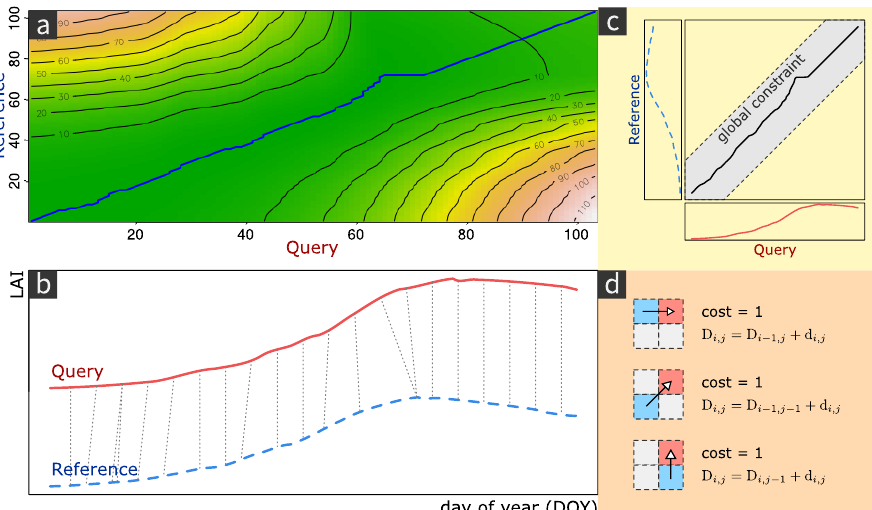
Figure 5. Dynamic time warping (DTW) algorithm and its constraints. ( a ) Density map of DTW warping costs. Warping costs increase from green to yellow. The blue line illustrates the warping path with the minimum cost. ( b ) DTW matches. The plot illustrates how points are related between the query series and reference series. ( c ) Global warping constraints. The search scope of the warping path is limited to a fixed distance from the main diagonal. ( d ) Local warping constraints and costs. The plot illustrates all possible choices of a warping step and the corresponding